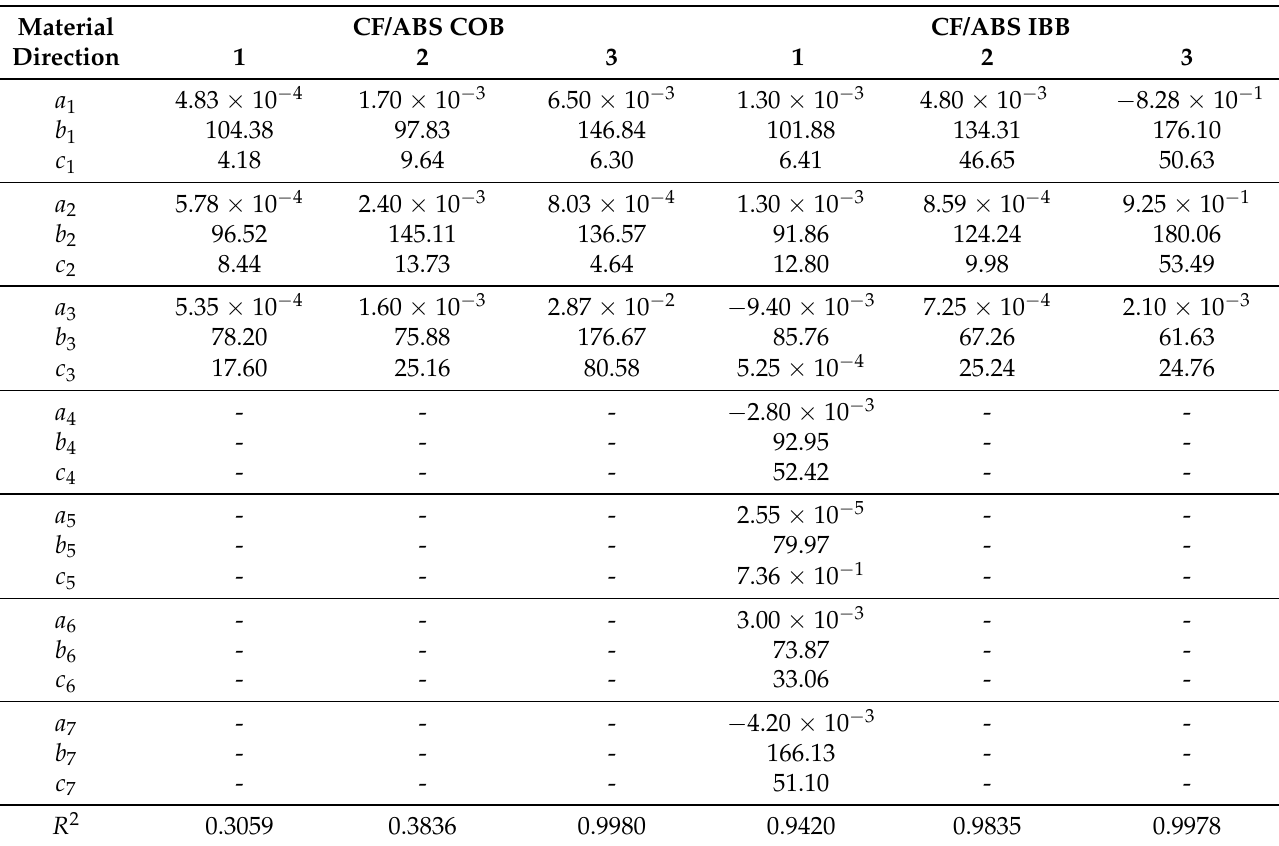
Table A1. Gaussian fitting parameters for CF/ABS material.